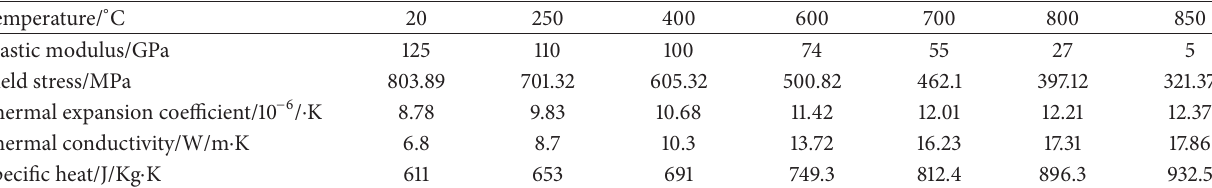
Table 2: Mechanical and thermal physical properties of Ti6Al4V titanium alloy.